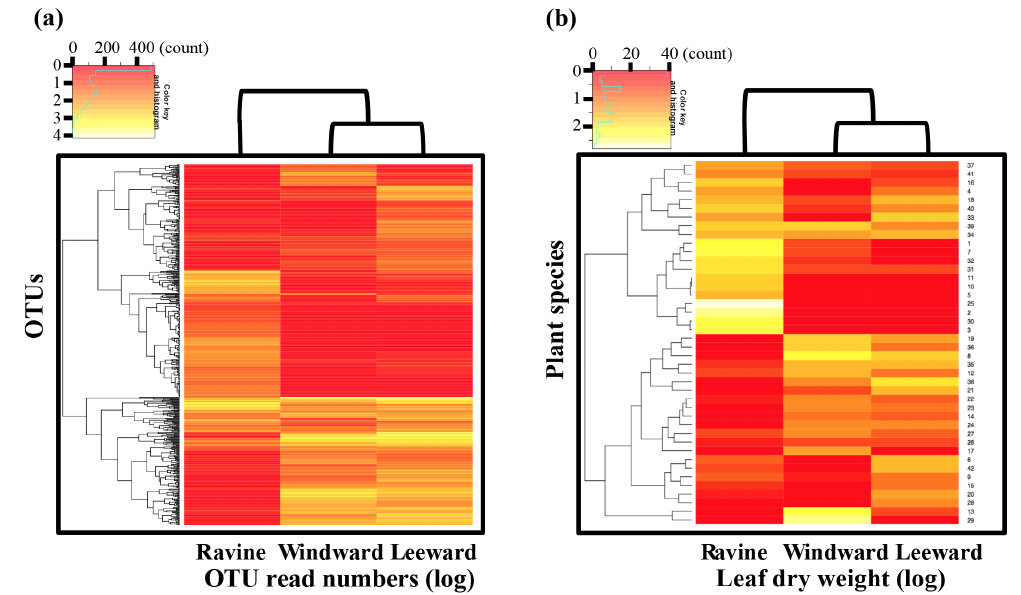
Figure 7. Heat map analysis of read number of OTUs and annual litterfall productions of each plant species in three habitats. (a) Heat map of read number of OTUs in three habitats. (b) Heat map of litterfall productions of plants in three